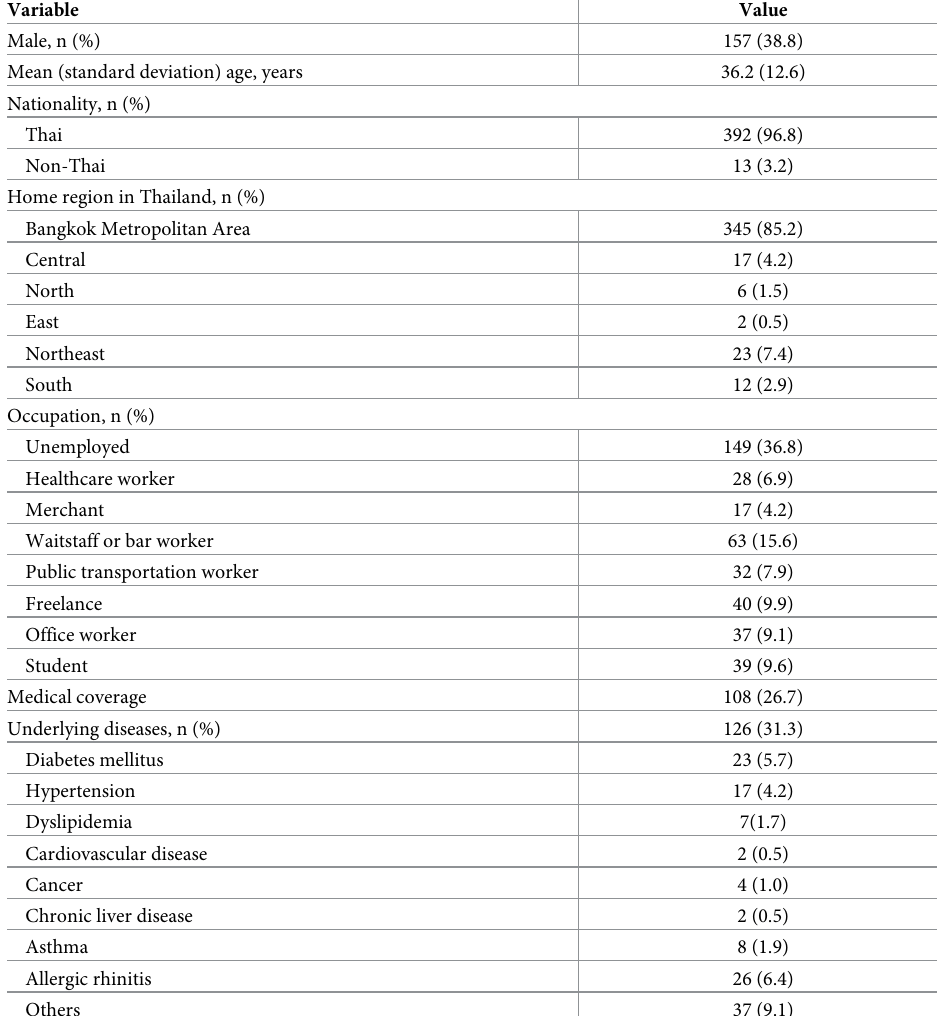
Table 1. Baseline characteristics of 405 patients under